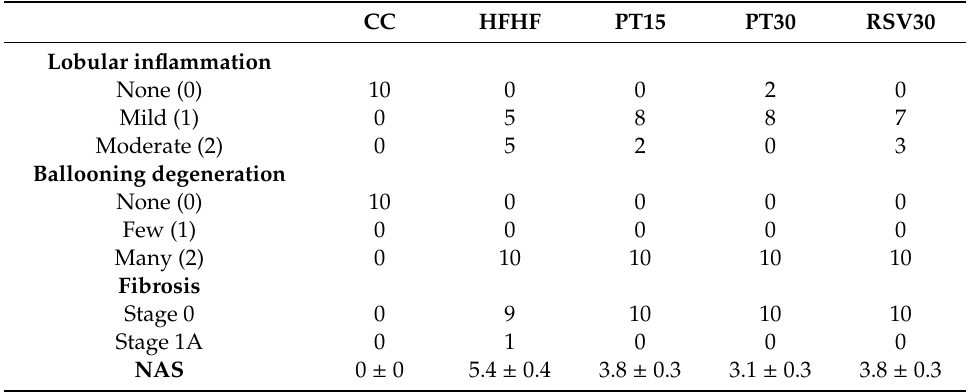
Table 2. Histopathologic characteristics of the livers of the rats fed with the experimental diets for 8 weeks. CC HFHF PT15 PT30